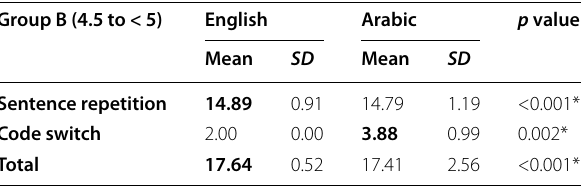
Table 13 Comparison between the scores of Arabic and English Narration Tests in the second story (the boy and his grandpa) test in age group